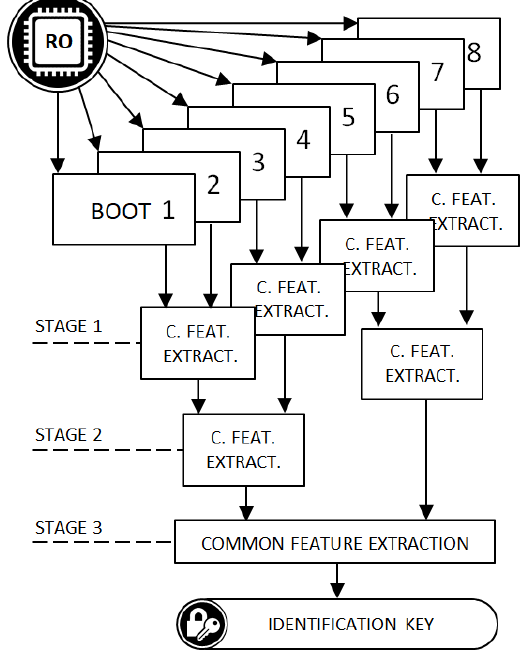
Figure 4. Boot-set data processing for obtaining the identification key in the tree-structured process of the extraction of multiple common